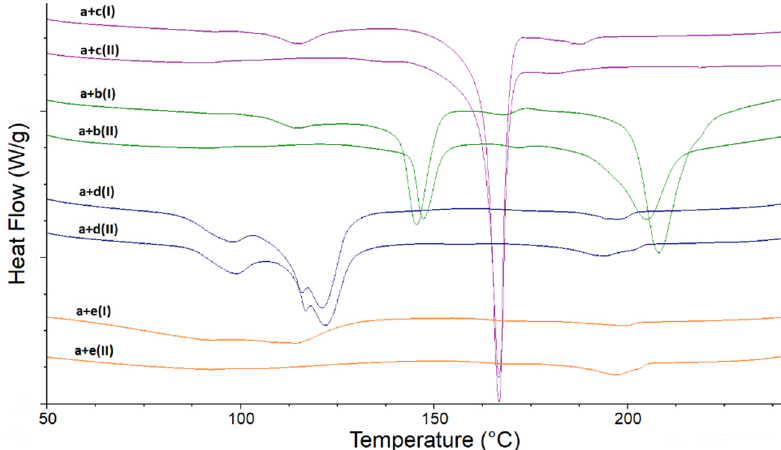
Figure 3. DSC curves for binary mixtures of linagliptin (a) with lactose (b), mannitol (c), magnesium stearate (d) and polyvinylpyrrolidone (e) in the non-stressed (I) and stressed (II) samples.